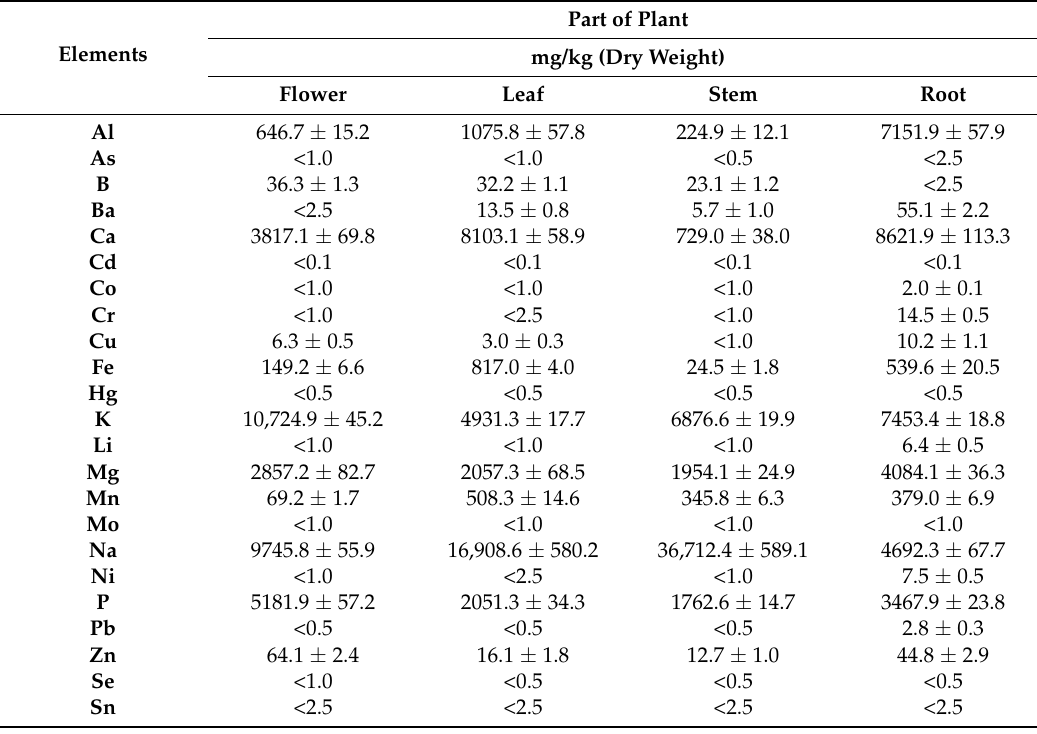
Table 4. Concentration of different elements in the dry residue of N. alba after ultrasonic extraction and ± standard deviation